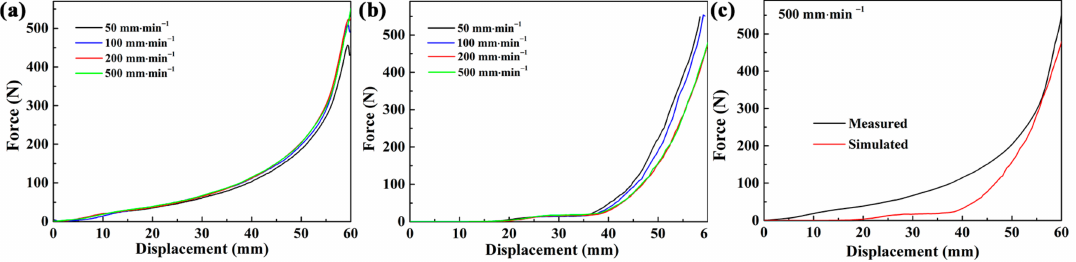
Figure 5. Compressive force–displacement curves of compression process: ( a ) measured, ( b ) simu- lated, and ( c ) comparison of measured and simulated process at 500 mm · min − 1 loading speed. Table 7. The maximum compressive force of measured and simulated tests and their relative error. Loading Speed